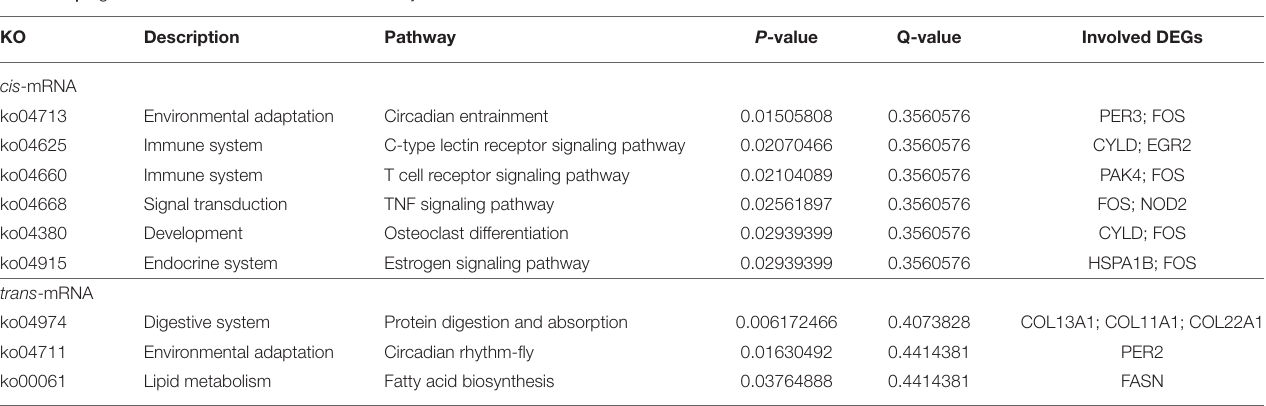
TABLE 3 | Significant results of KEGG enrichment